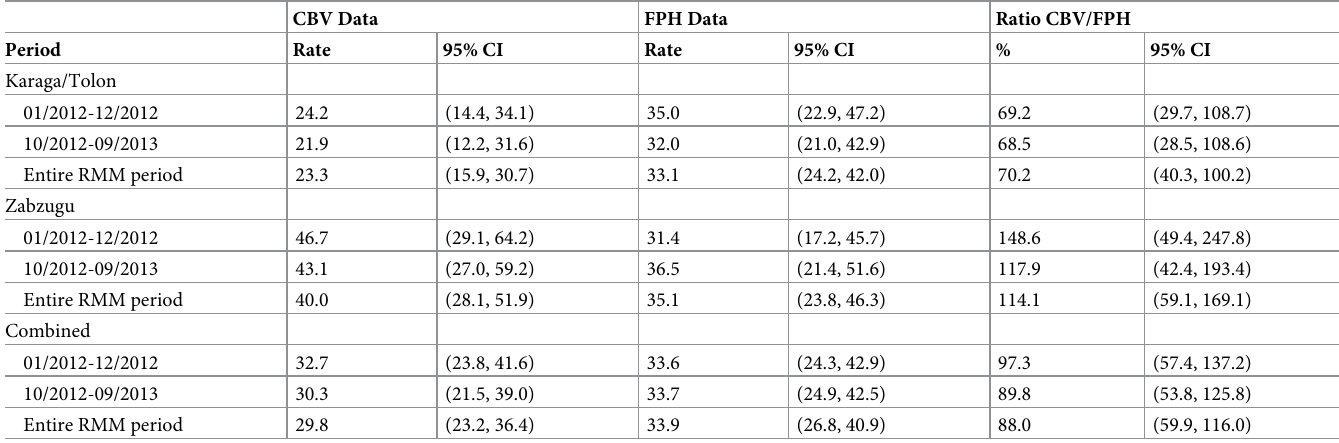
Table 5. Infant mortality rates estimated from CBV records and FPH data and corresponding 95% confidence intervals. CBV